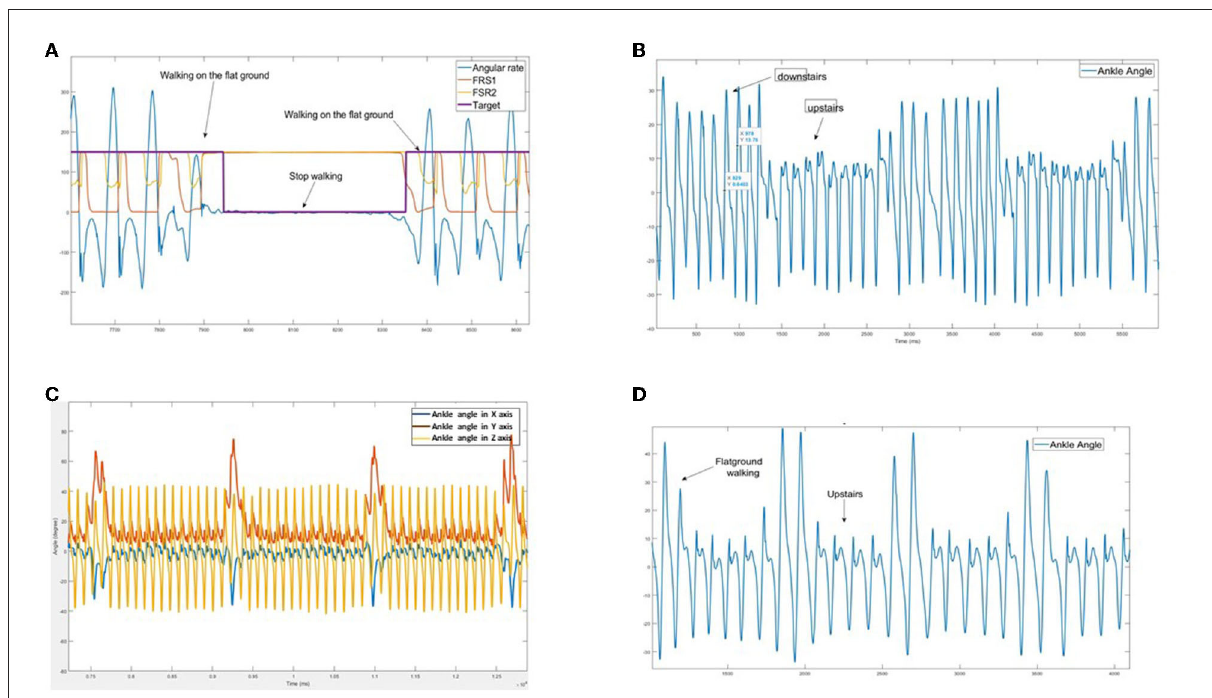
FIGURE1 Observation signal patterns of the inertial measurement unit (IMU) on different walking surfaces: resultant angular velocity (rad/s) and Force Sensitive Resistor (FSR) sensors. The distinguished characteristics of tanks (A) level ground walking (LW) and standing (ST); (B) stair descent (SD) and stair ascent (SA); (C) FW and turning; (D) FW and SA. We use all six input signals of tri-gyroscope and tri-accelerometer for the training models; however, significant signals are depicted in this figure.